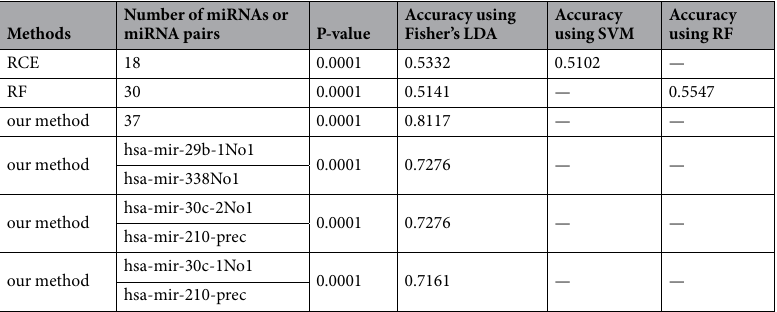
Table 1. Comparisons among RCE 33 , RF 35 and our method on dataset GSE6857.